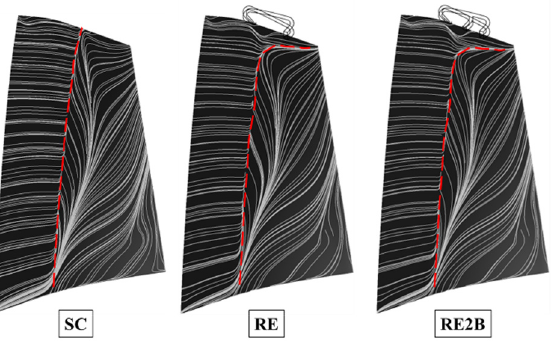
Figure 7. Streamlines on suction surface of rotor blade at near-stall condition.